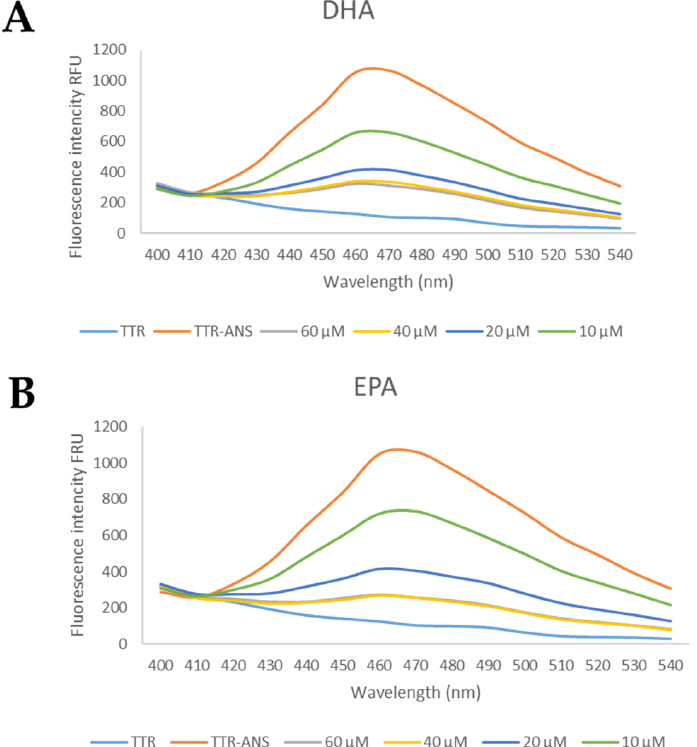
Figure 5. The general profile of ANS displacement binding assay for studied compounds. ( A ) The TTR-ANS complex was titrated with different concentrations of EPA and ( B ) of DHA.